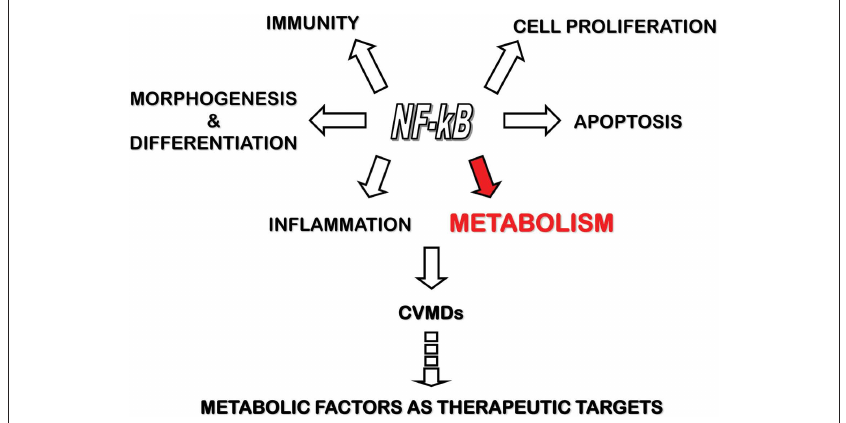
Figure 1 | The control of inflammation and metabolism by NF- κ B and its relevance to CVMDs. NF- κ B transcription factors control several physiologic functions, including morphogenesis and differentiation, cell proliferation and apoptosis, immunity and inflammation. Recent work has shed light in the control of cell energy metabolism by NF- κ B. By regulating both inflammatory and metabolic pathways, NF- κ B has been involved in the pathogenesis of CVMDs, thereby opening the way to the identification of metabolic factors under NF- κ B control as target for